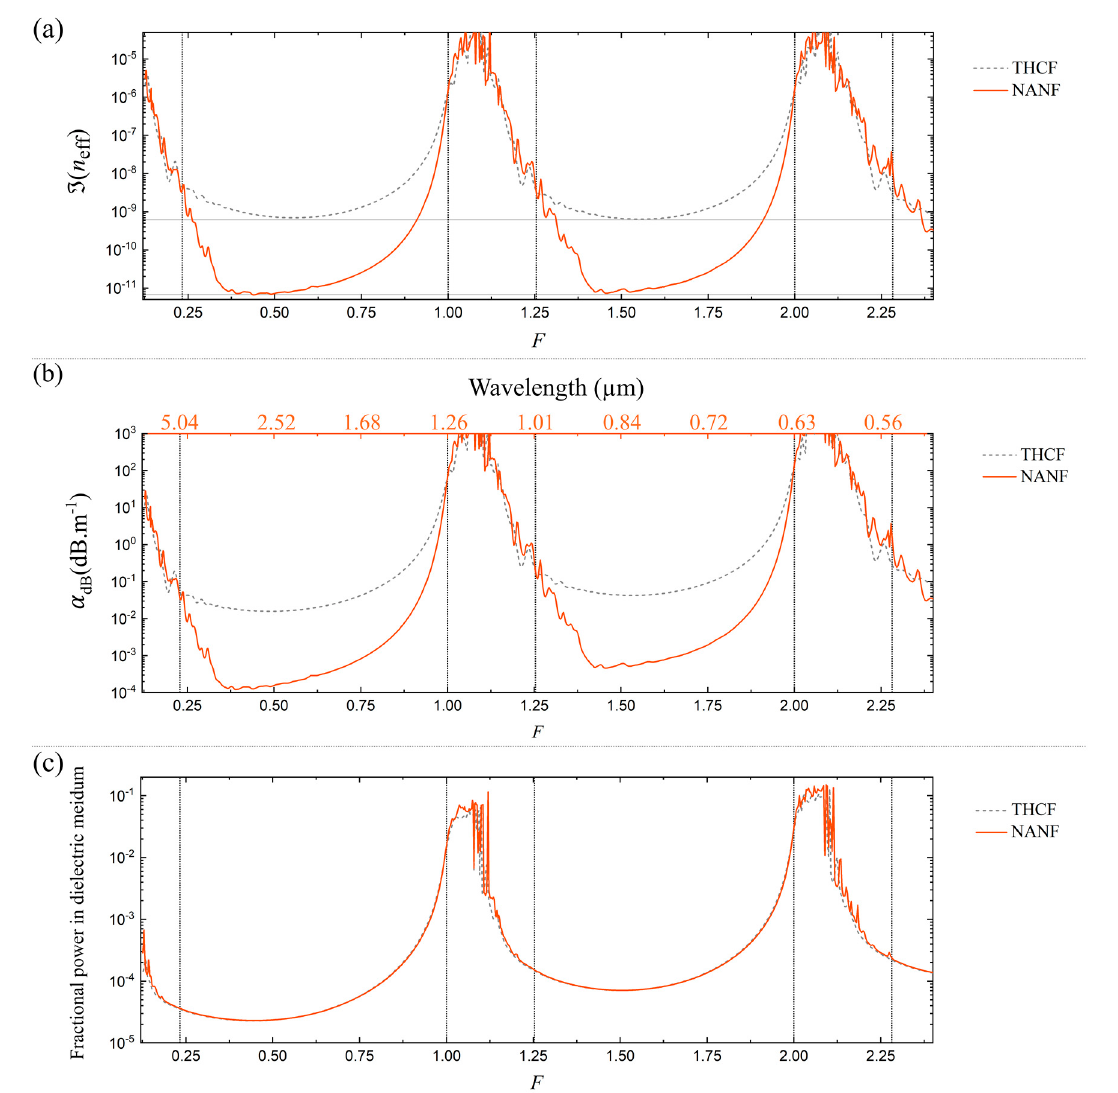
Figure 4. ( a ) Imaginary part of the fundamental core mode index, (cid:61) ( n eff ) , as a function of F in a six-tube NANF when G = 25 and d 1 / D = 0.65, and d 1 = 2 d 2 . ( b ) Corresponding confinement loss versus wavelength when t = 0.6 µ m. ( c ) Fractional optical power in the dielectric medium in the same NANF. The same quantities for THCF with the identical geometrical parameters are plotted in gray-dashed lines for comparison.